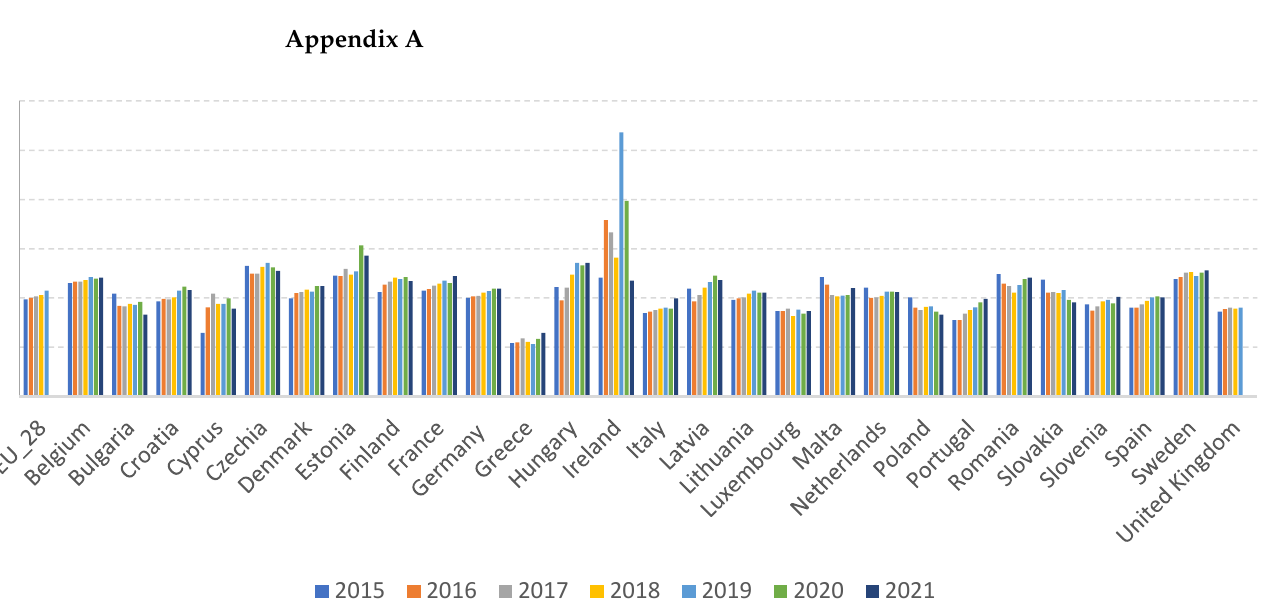
Figure A2. Greenhouse gas emissions intensity of energy consumption by EU27 country in 2020. Index, 2000 = 100. Source: own elaboration based on [27].